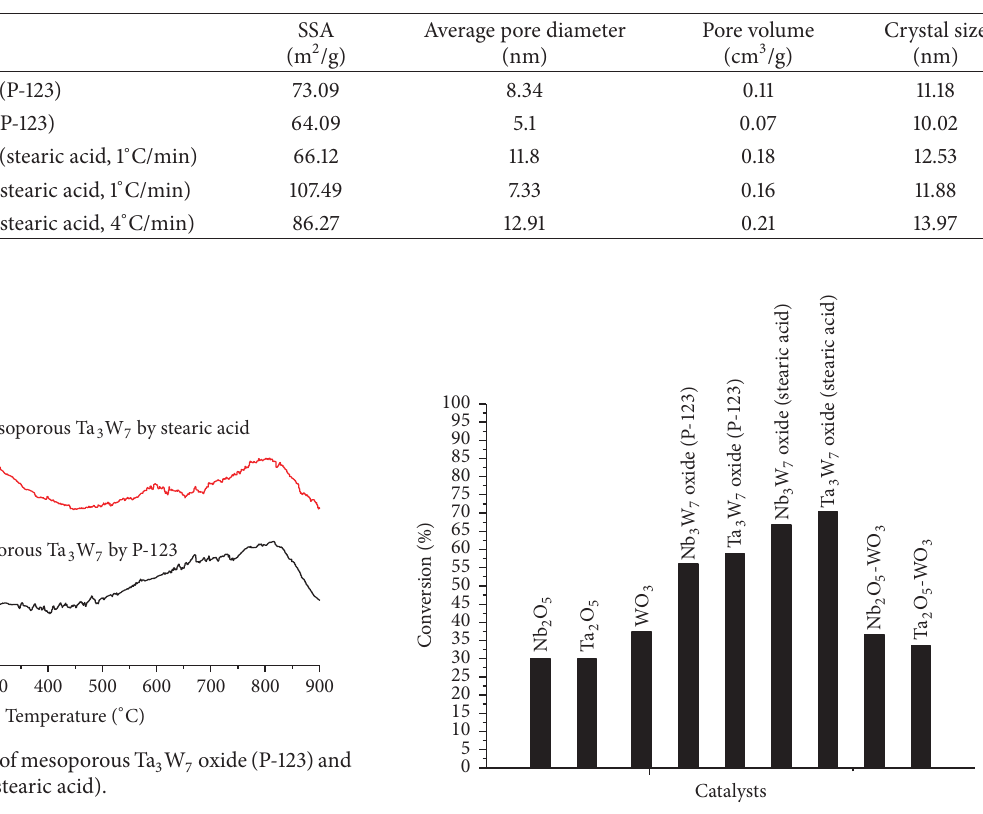
Table 1: Physicochemical properties of catalyst samples.